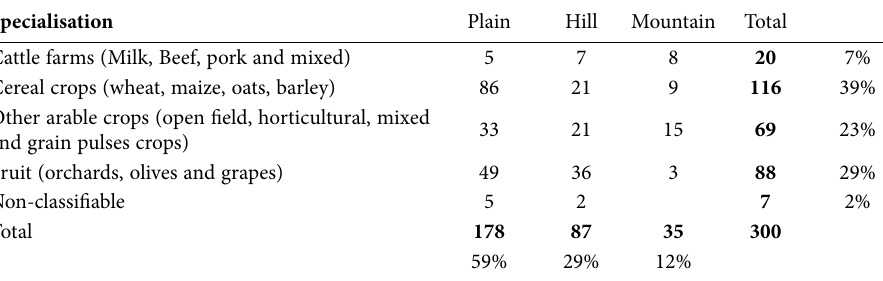
Source: our elaboration of primary data